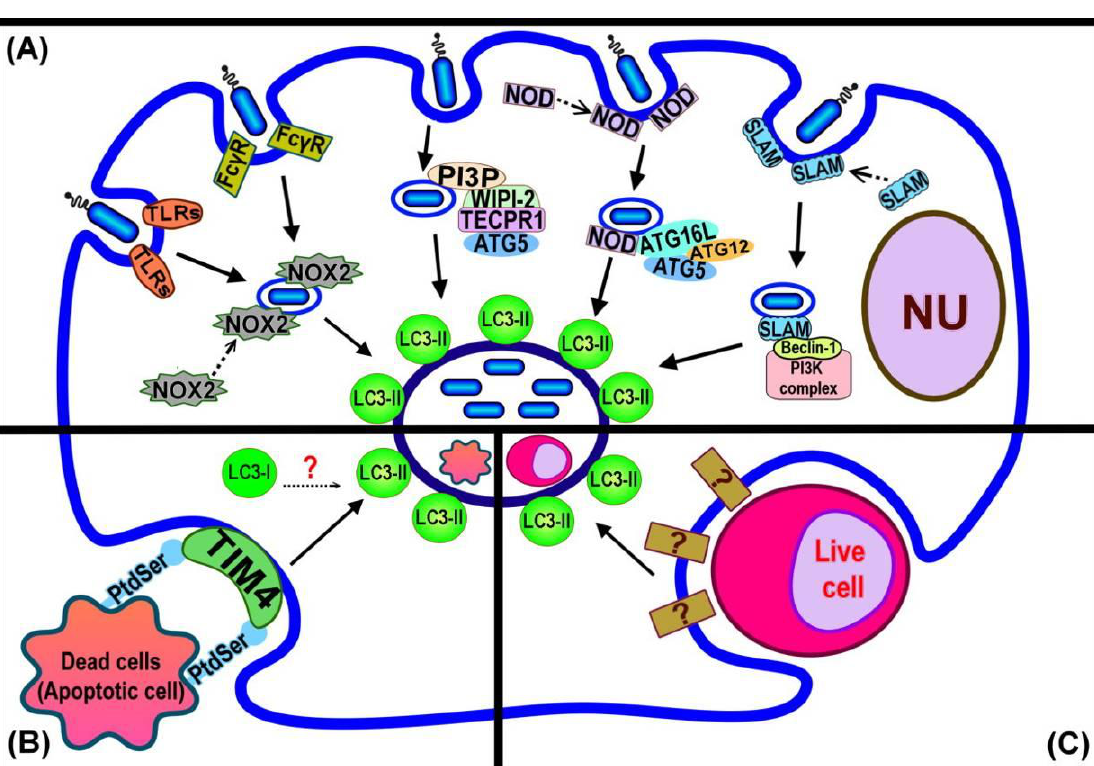
Figure 2. Summary of LC3-associated phagocytosis (LAP) pathways and current